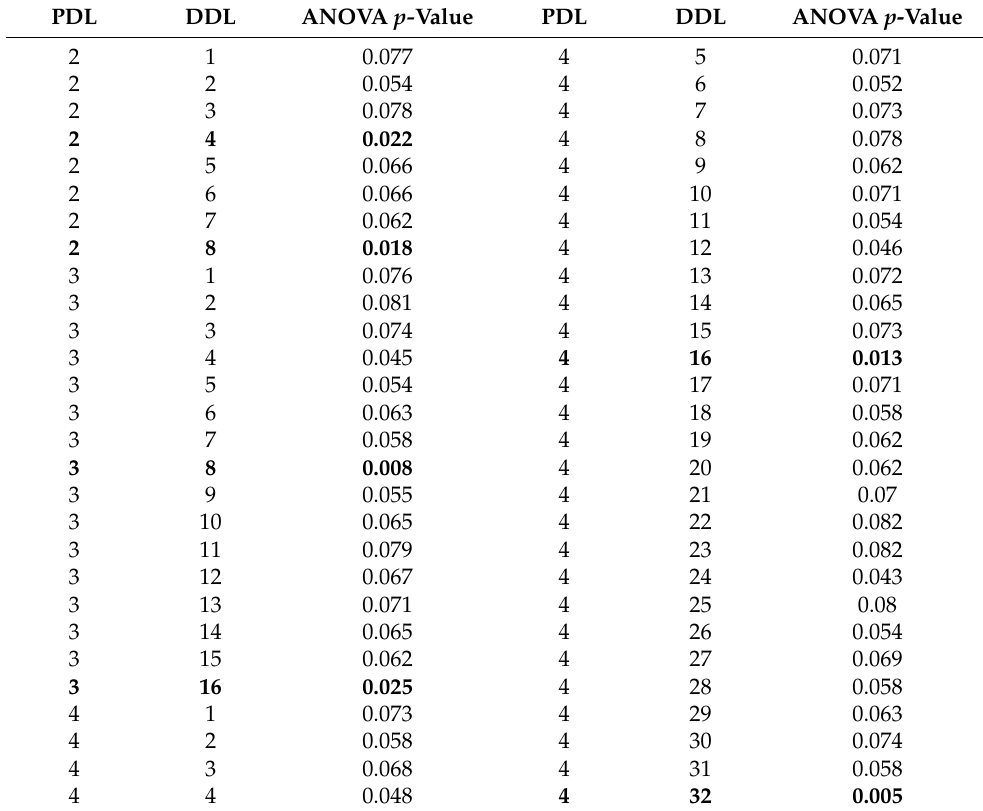
Table 2. Suitability of six Contourlet sub-band coefficients considering ANOVA p -values (95% confidence), where PDL means Pyramidal Decomposition Level and DDL means Directional Decom- position Level.